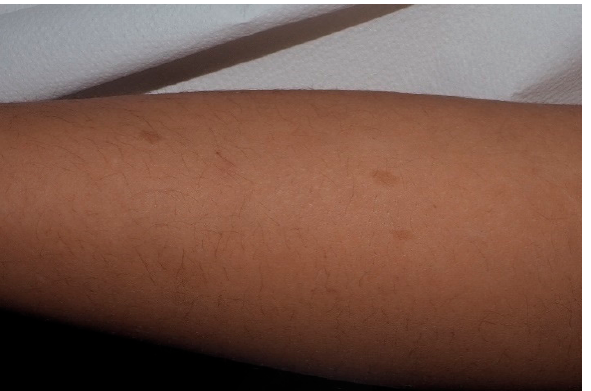
Figure 3. For this child, CALMs were detectable on lower limbs. Note that the size is larger than 5 mm and the typical well-demarcated borders.